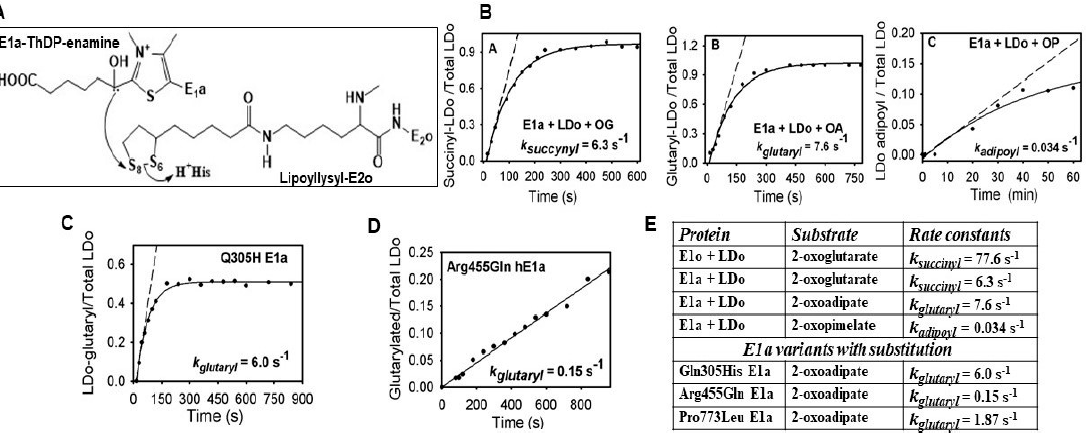
Figure 2. Reductive acylation of the E2o lipoyl domain (LDo) by E1a and E1a variants with muta- tions. ( A ) Reaction mechanism of the adipoyl group transfer between the E1a and E2o. ( B ) Reductive acylation of the LDo by E1a and substrates of the different chain length: OG (C5), OA (C6) and OP (C7). ( C ) Reductive glutarylation of the LDo by Gln305His E1a and OA. ( D ) Reductive glutarylation of the LDo by Arg455Gln E1a and OA. ( E ) Comparison of the kinetic constants for reductive acylation of LDo by E1a and E1a variants with mutations. Relative intensity of the adipoylated LDo versus total LDo (adipoylated plus un-adipoylated) was analyzed by FT-MS and was plotted versus time. Data points were fit to equation (y = yo + a × (1 − e − kt )). The trace is a nonlinear regression fit to initial rate conditions. The k adipoyl was calculated from the initial slope. See Materials and Methods for details of experiment.